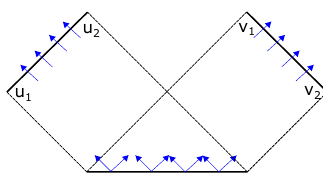
Figure 14 . Decomposition of entanglement entropy in 2d CFT in decoupled left- and right- moving